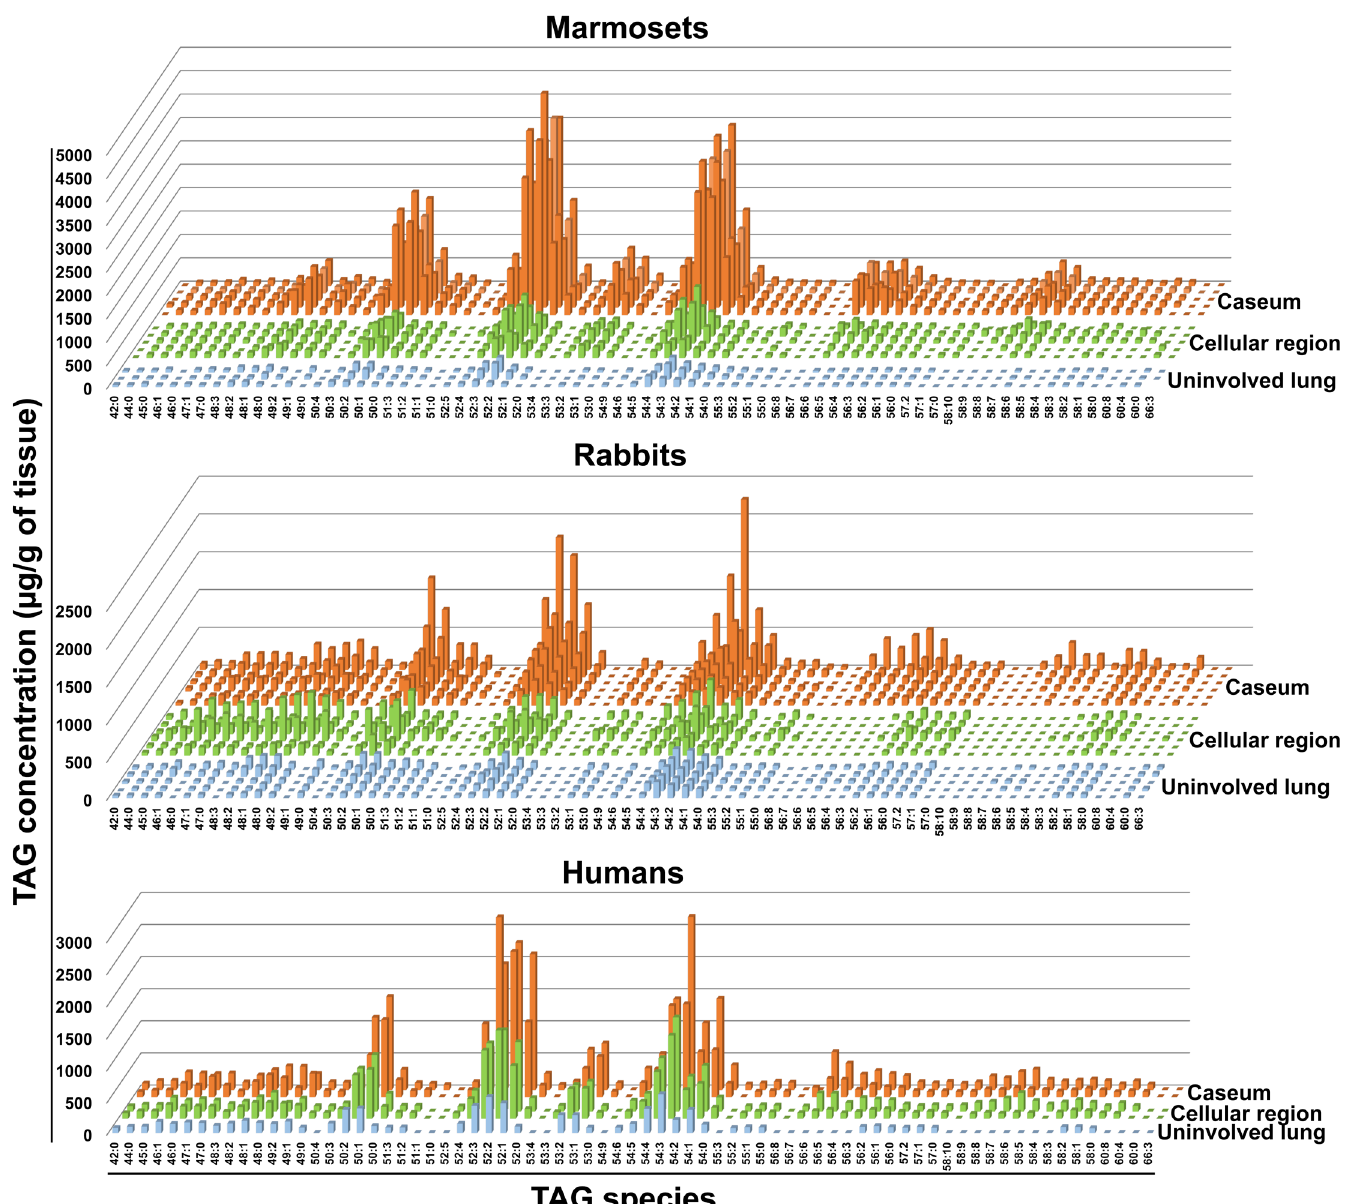
Fig 2. TAG species profiles in pulmonary tuberculous lesions of rabbits, marmosets, and humans. TAG species in microdissected areas of caseum and cellular regions of lesions, and uninvolved lung areas were quantified by LC-MS. In all graphs, each line represents one sample: uninvolved lung areas (light blue), cellular region (green), and caseum (orange). Marmosets: five lesional and three uninvolved lung areas (from four animals). Rabbits: six lesional and five uninvolved lung areas (from six animals). Humans: two lesional areas (one per patient) from two active tuberculosis cases, and one uninvolved lung area (from one of the two patients). One of the dominant species in this figure (TAG 52:2) was revealed by the electrospray ionization mass spectrometry analysis of human tuberculous caseum in a previous study [85].